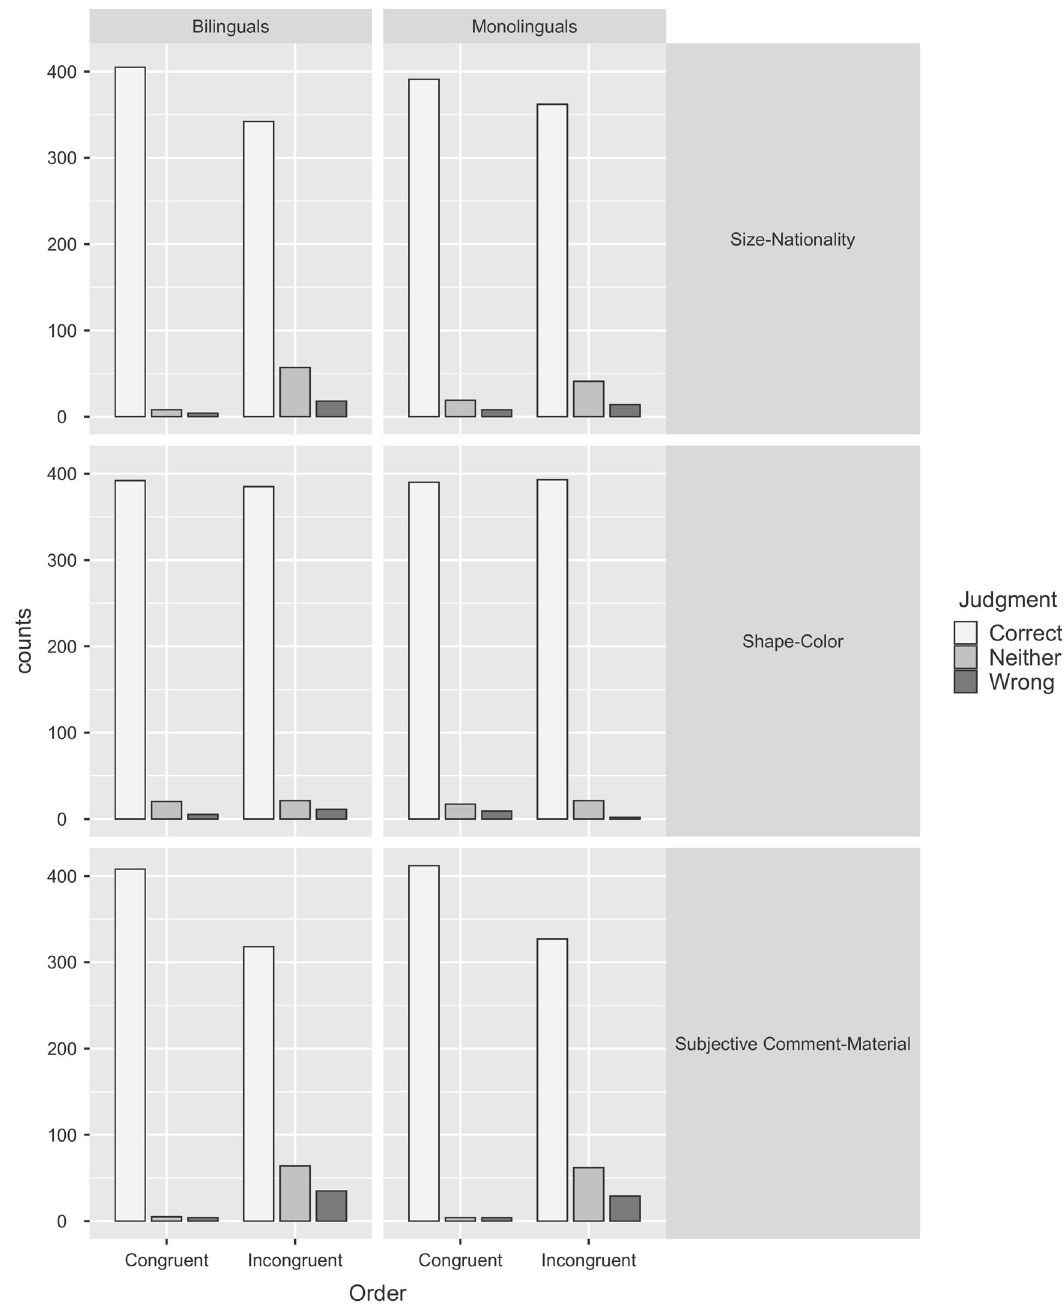
Fig. 9 Comparison of judgments across orders and conditions in the two populations: monolinguals and bilinguals. The comparison is between the bilingual participants of the present experiment and the monolingual participants of Leivada & Westergaard (2019).